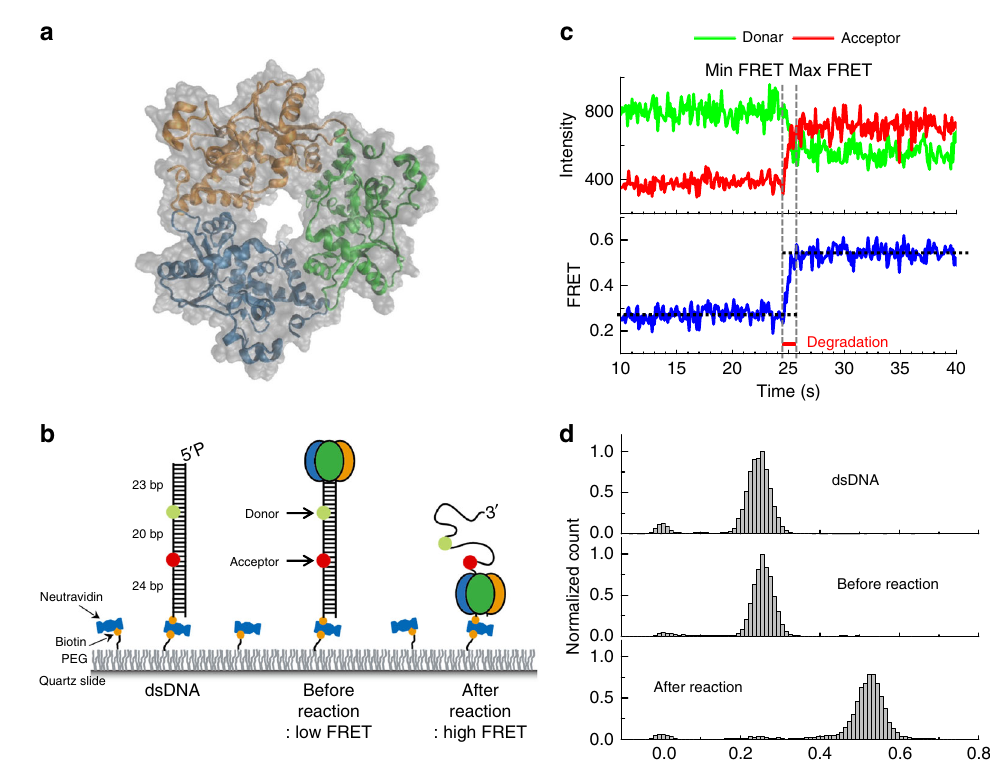
Fig. 1 Real-time measurements of processive degradation by λ -exonuclease. a The crystal structure of λ -exonuclease (PDB entry 1AVQ). b Experimental layout, depicting the DNA, protein binding to DNA, and processive degradation. c Schematic showing how the degradation time is measured using FRET signal. d Single-molecule FRET histogram obtained as in b (top: dsDNA only; middle: before the degradation in the absence of Mg 2 + ; and bottom: after the degradation in the presence of Mg 2 +